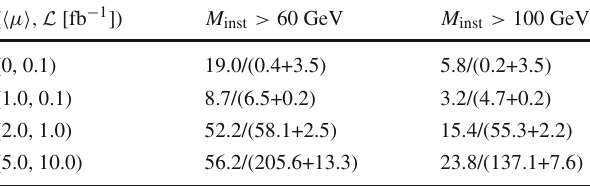
Table 1 Summary of event yields after applying cuts in Eqs. (9) and (10) for the single-tag search approach for M inst > 60 GeV and M inst > 100 GeV, respectively, and for four luminosity scenarios ( (cid:2) μ (cid:3) , L ). For each scenario, a ratio of number of signal to background events, N S /( N ND + N SD ) , is